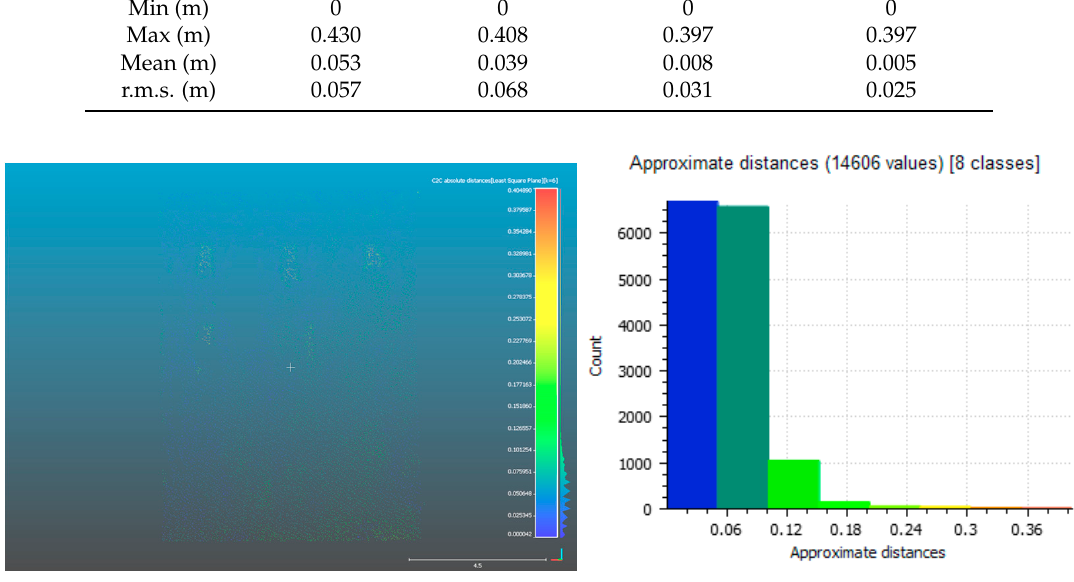
Figure 25. Discrepancy map and histogram between the TLS cloud and UAV Nadir in Photoscan.